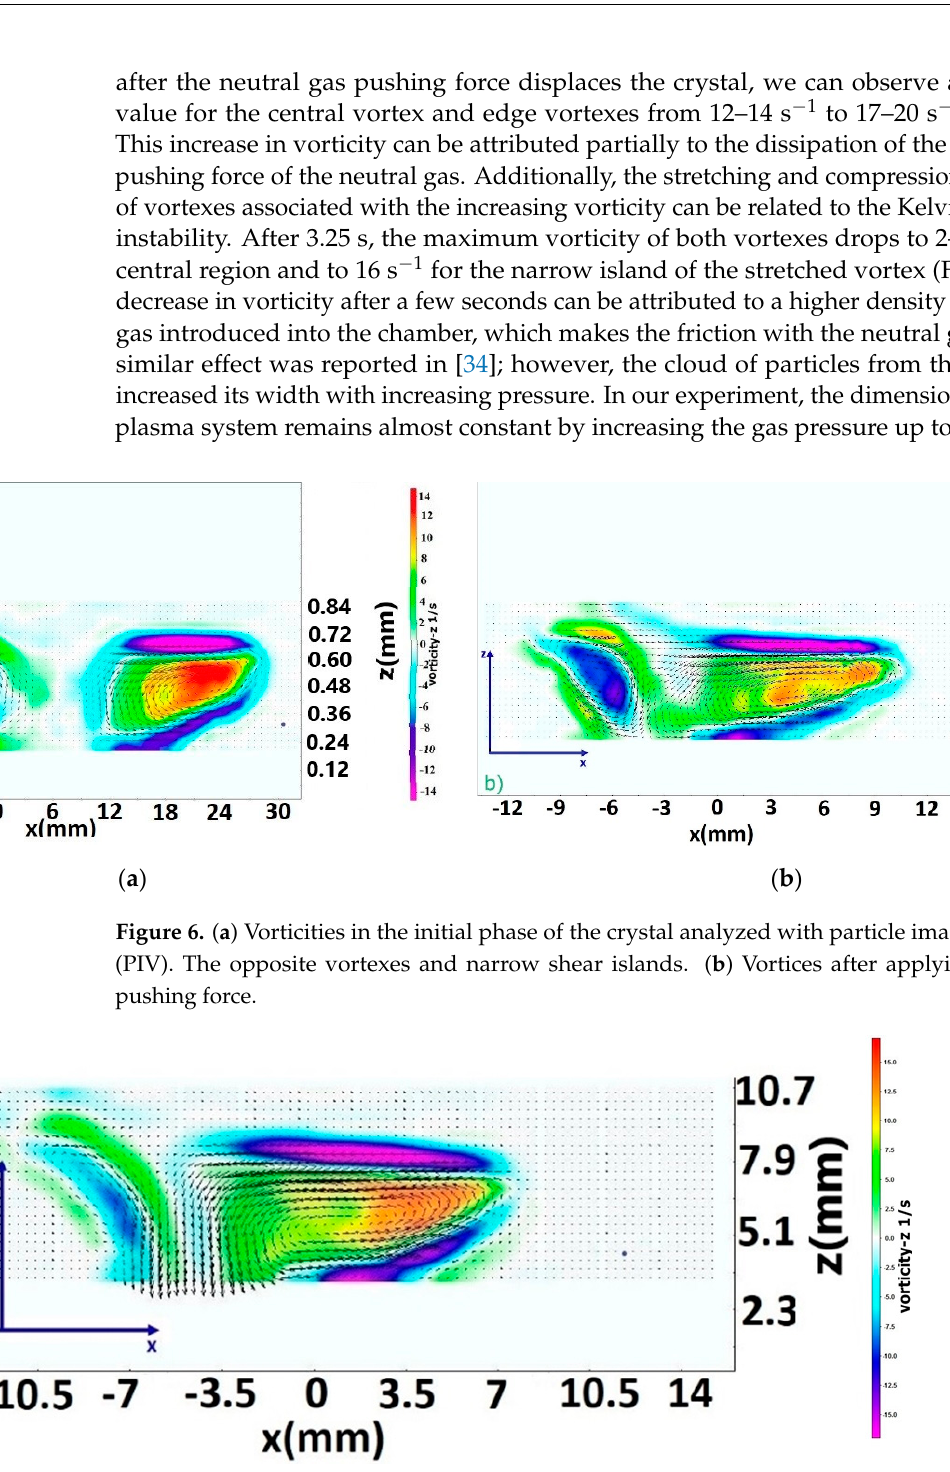
ϑ = 0.01 cm − 2 s − 1 ; the velocity of dust, v = 2.84 cm/s and D= 0.8 cm; and the diameter